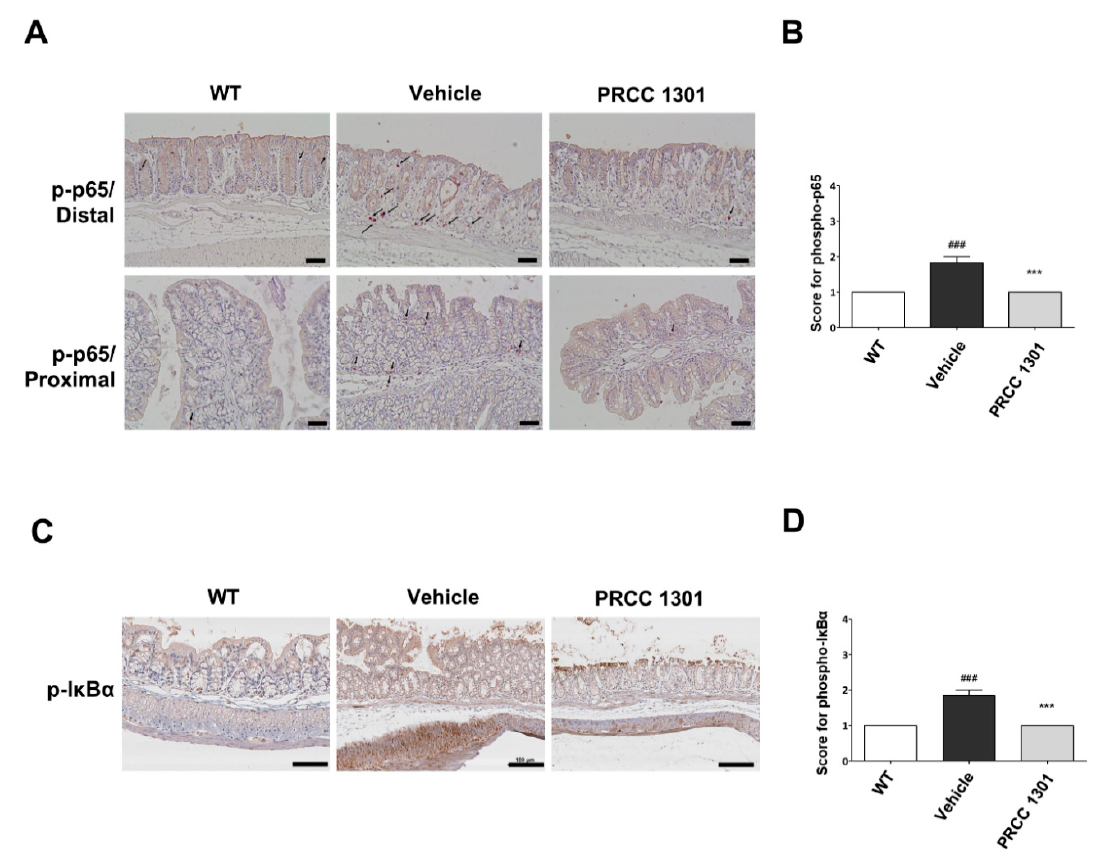
Figure 4. PRCC-1301 EVs suppressed NF- κ B activation in DSS-induced acute colitis. Representative images of Immunohistochemistry (IHC) staining of phospho-NF- κ B p65 and phospho-I κ B α in 3 mg / kg of PRCC-1301 EV-treated mice. ( A , B ) The expression of phospho-NF- κ B p65 in DSS-induced colitis mice. The arrow indicates phospho-NF- κ B p65 positive cells. The expression of phospho-I κ B α in ( C , D ) DSS-induced colitis. The results are shown as mean ± SEM. ### p < 0.001 compared with WT, *** p < 0.001 compared with vehicle group. Scale bar = 100 μ m .